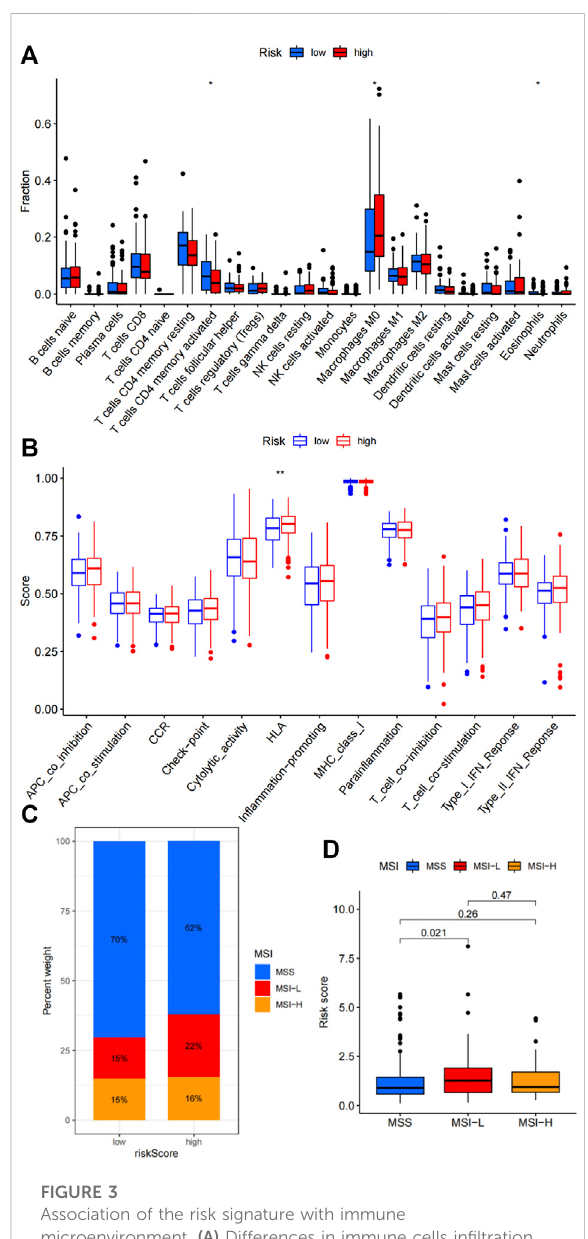
FIGURE 3 Association of the risk signature with immune microenvironment. (A) Differences in immune cells in fi ltration between high-risk and low-risk groups. (B) Correlations between the risk signature and various immune functions. (C) Percent weight of MSI status between high-risk and low-risk groups. (D) Comparison of risk scores among MSS, MSI-L and MSI-H